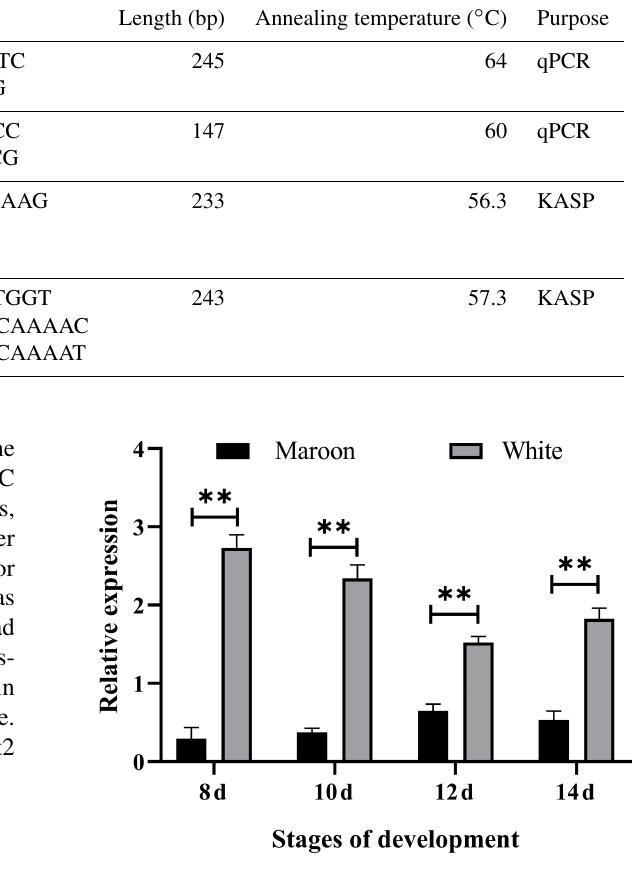
Figure 1. The mRNA expression levels of the MLPH gene in dif- ferent embryonic development stages of Korean quail and Beijing white quail. Symbols ∗∗ mean that the difference between quail embryos with different plumage colors at the same developmental stage is significant ( P< 0 .